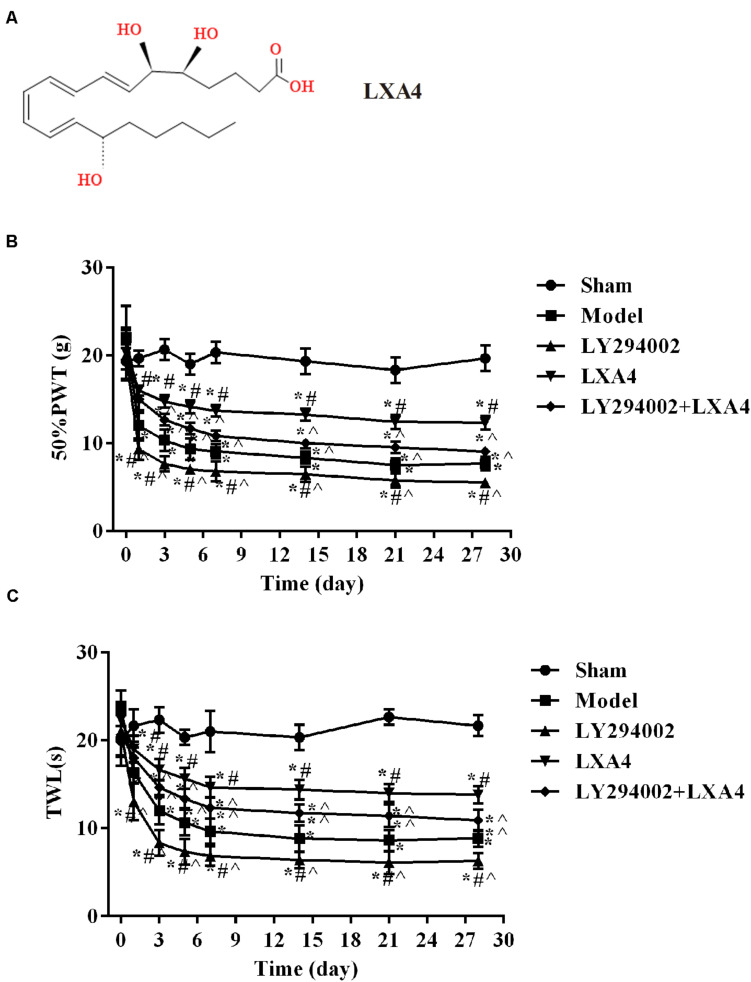
Comparison of 50% mechanical pain threshold (paw withdrawal threshold, PWT) and thermal pain threshold (thermal withdrawal latency, TWL) at different time points in each treatment group. (A) The complete stereochemistry of LXA4; (B) 50% PWT; (C) TWL. *p < 0.05 compared with the sham group; #p < 0.05 compared with the model group; ∧p < 0.05 compared with the LXA4 group. Experiments were repeated three times for each group. Data are presented as means ± standard deviation (SD). One-way analysis of variance (ANOVA) was used for comparisons among groups followed by Dunnett’s t-test.